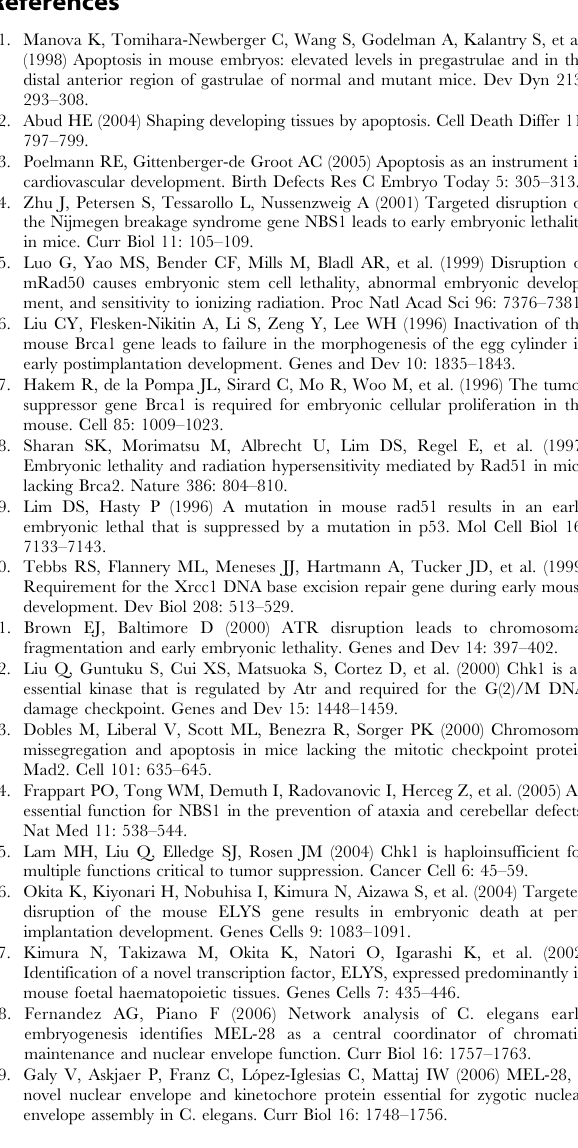
Table S1 Reduced cell proliferation in the flo intestine. Percentage of S-phase cells is reduced in the 75 hpf flo intestine vs. wild type siblings as determined by BrdU immunohistochem- istry. The percentage of phospho-Histone H3 cells is comparable in flo and wild type larvae. These data are consistent with G1 arrest. Table S2 Reduced cell proliferation in the flo retina. Data derived from FACS of freshly dissociated retinal epithelial cells from flo and sibling wild type larvae. Sorting performed